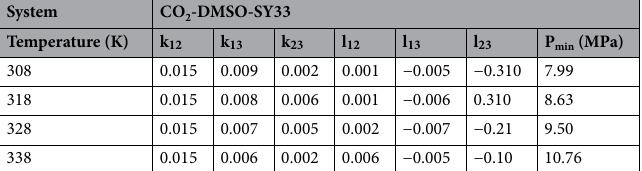
Table 5. Binary interaction parameters from PR-EoS with the vdW2 mixing rule for the ternary system (CO 2 (1)—DMSO (2)–SY33 (3)).